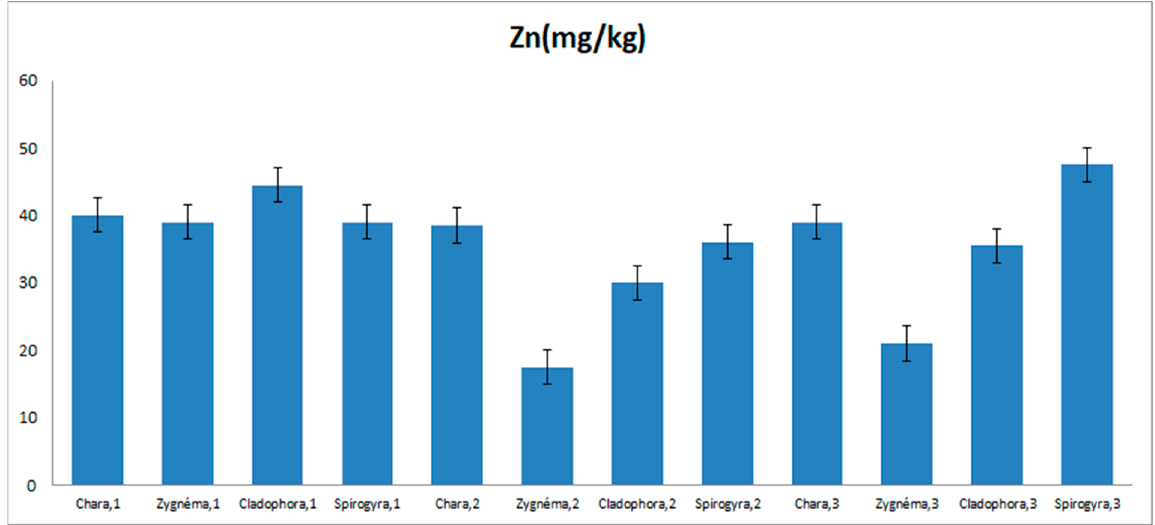
Figure 4. Zn contents of the four algae studied (for the three sites considered).